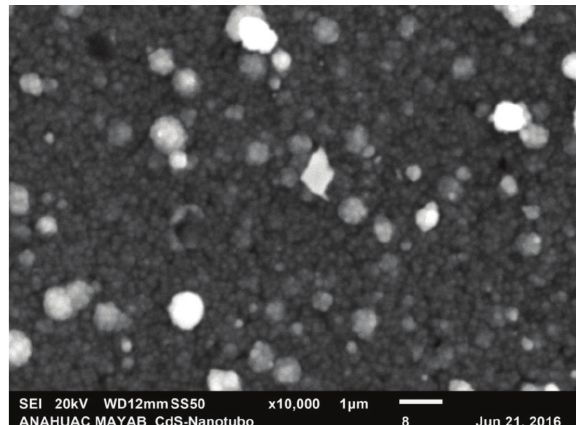
Figure 5: SEM image of the CdS film deposited by CBD onto MWCNT/PSF polymeric